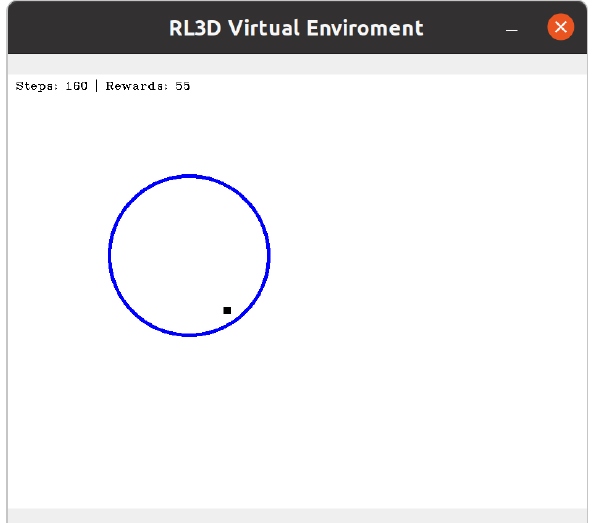
Figure 5. Example of a robot trajectory recorded in the virtual